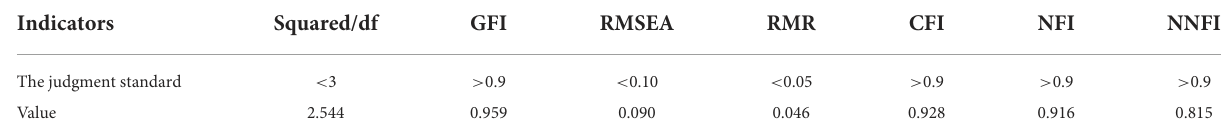
TABLE 5 The confirmatory factor analysis of residents’ satisfaction with the home fitness questionnaire during the epidemic period showed that the fitting degree met the requirements. Indicators The judgment standard